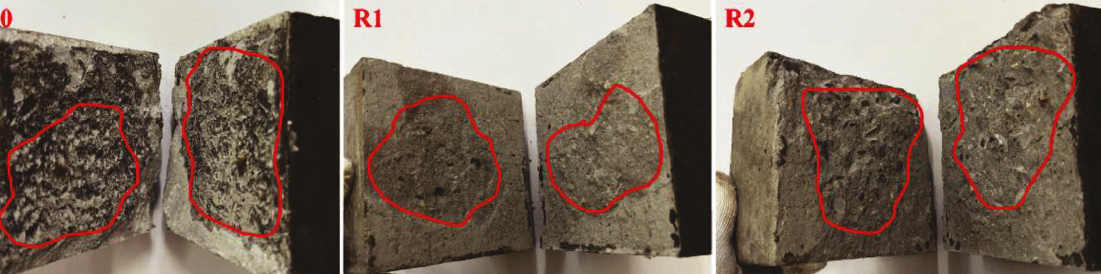
Figure 23: Damage patterns of bond splitting test.